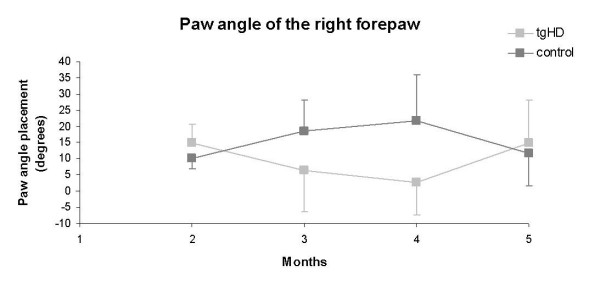
Catwalk automated analysis of paw angle placement of tgHD and normal rats between 2 and 5 months of age. At 3 and 4 months the right forepaw angle placement of the tgHD rats was deviated in comparison to the wild-types. Data are shown as mean ± s.e.m. * p < 0.03.